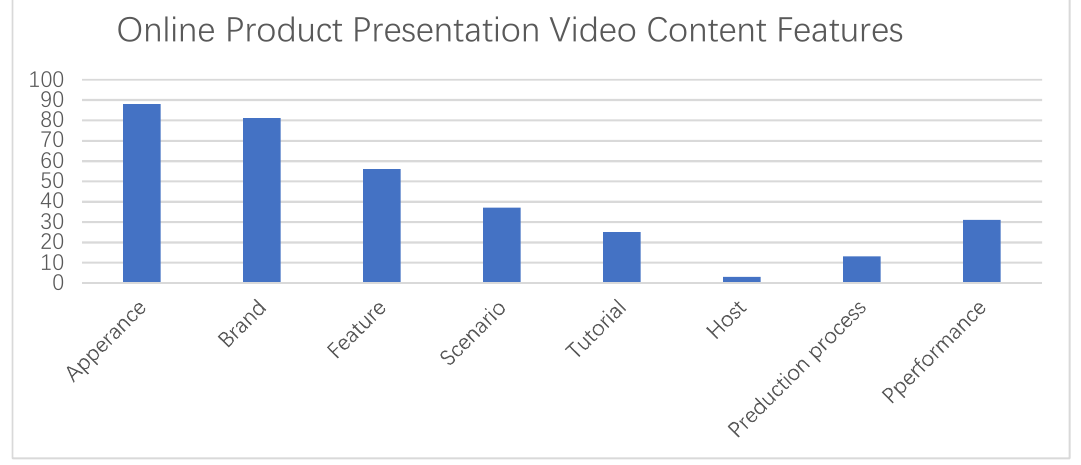
Figure 1. The classified statistics of short video content features.